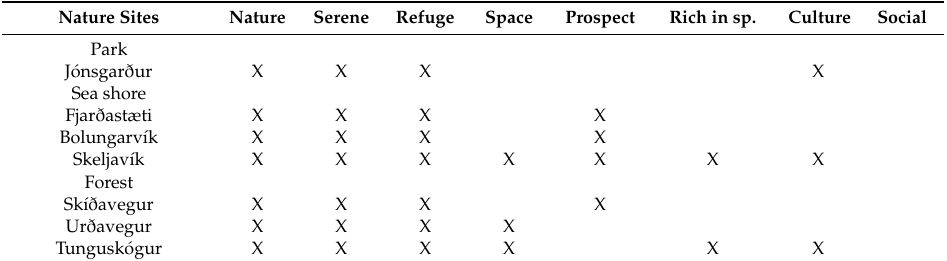
Table 3. Overview of PSDs that participants experienced at the nature